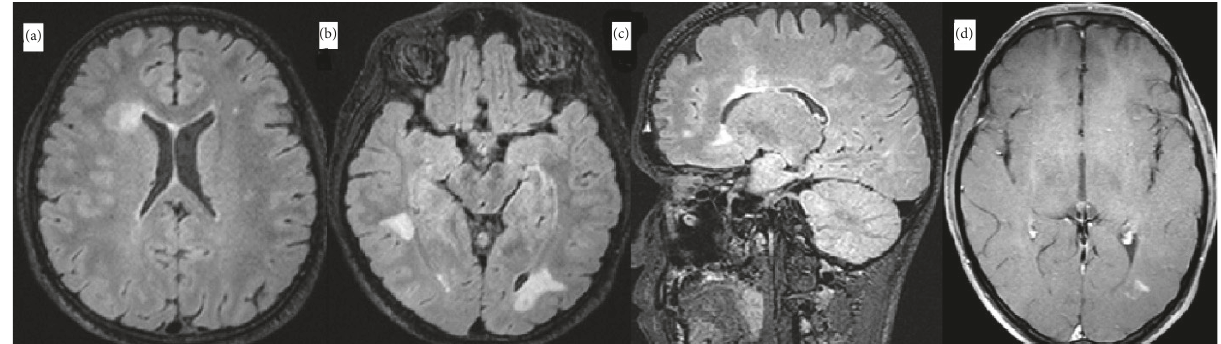
Figure 3: One year later. (a) Regression of tumefactive lesions is evident. (b) Axial fluid attenuation inversion recovery (FLAIR) image shows new hyperintense lesions in the bilateral parietooccipital white matter. (c) Sagittal FLAIR image demonstrates periventricular, cortical/juxtacortical demyelinating lesions. (d) T1-weighted postcontrast image shows contrast enhancement of the lesion in the left parietooccipital white